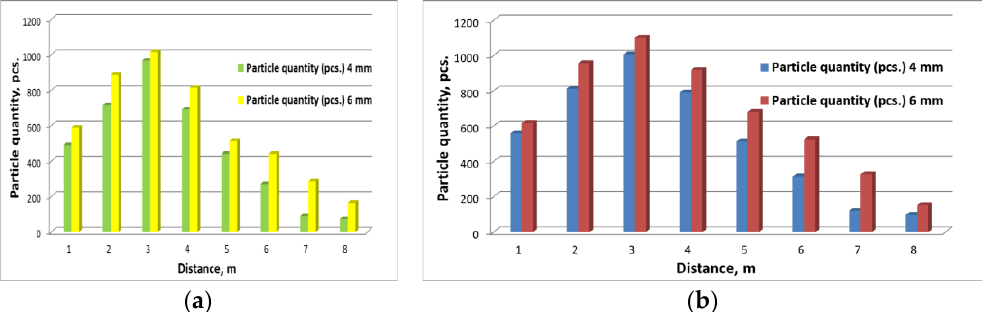
Figure 10. Spreading of fertilizer granules obtained at a disc rotation speed of 600 min −1 : ( a ) normal discharge flow rate of 200 g s −1 ; ( b ) normal discharge flow rate of 400 g s −1 .